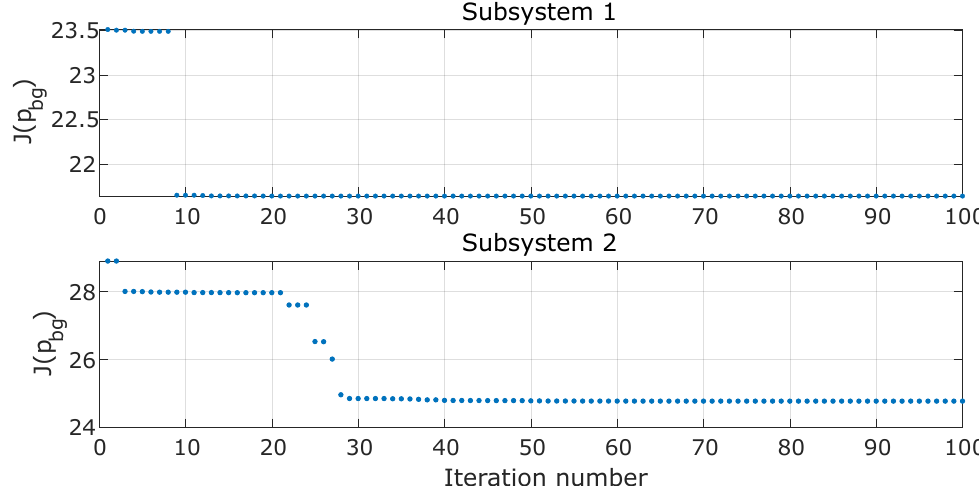
Figure 12. Value of the cost function used in the optimization of the power-estimation system, evaluated according to the value of the particle with the best cost of each